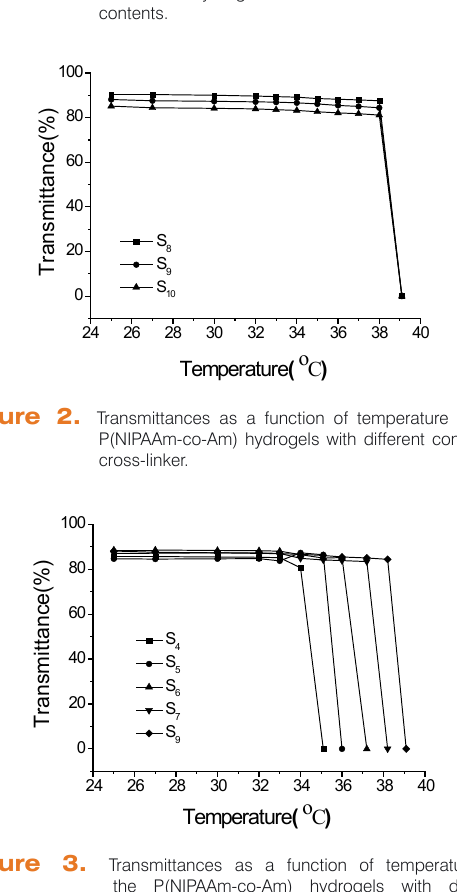
Figure 1. Transmittances as a function of temperature for the PNIPAAm hydrogels with different cross-linker